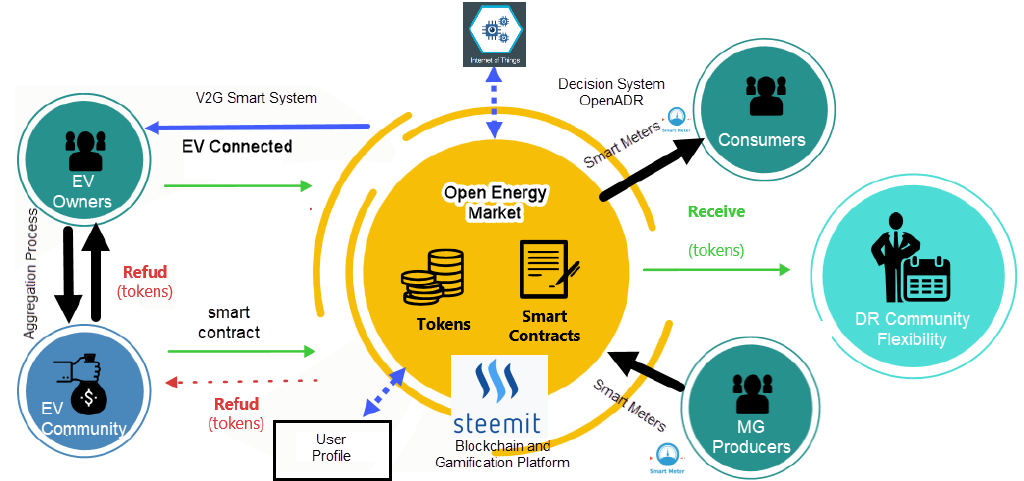
Figure 2. A proposed approach based on Steemit and Watson IBM platforms.